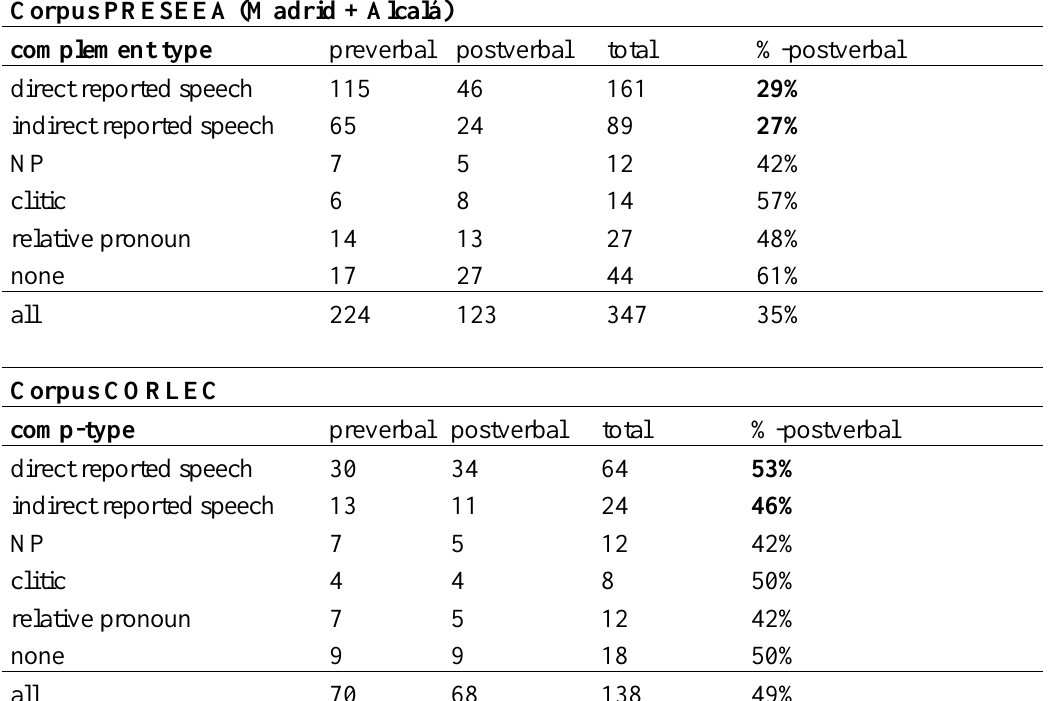
Table 9. Subject position according to complement type in the two corpora PRESEEA and